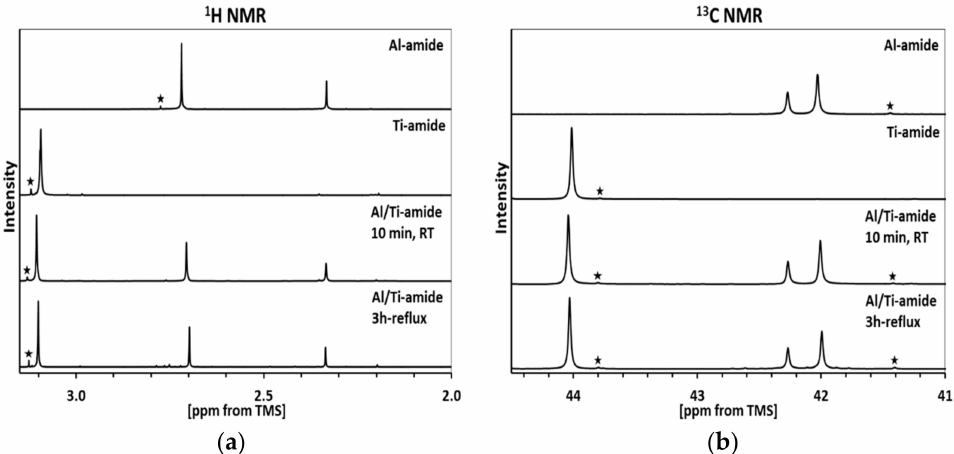
Figure 2. 1 H ( a ) and 13 C ( b ) nuclear magnetic resonance (NMR) spectra in C 6 D 6 of individual M-dimethylamides (M = Al or Ti) and bimetallic mixtures of Al/Ti-dimethylamides for two initial precursor processing routes/equilibration pathways. Small intensity peaks with asterisk indicate very low contamination levels of a compound’s decomposition products formed during their final purification by vacuum sublimation/distillation.